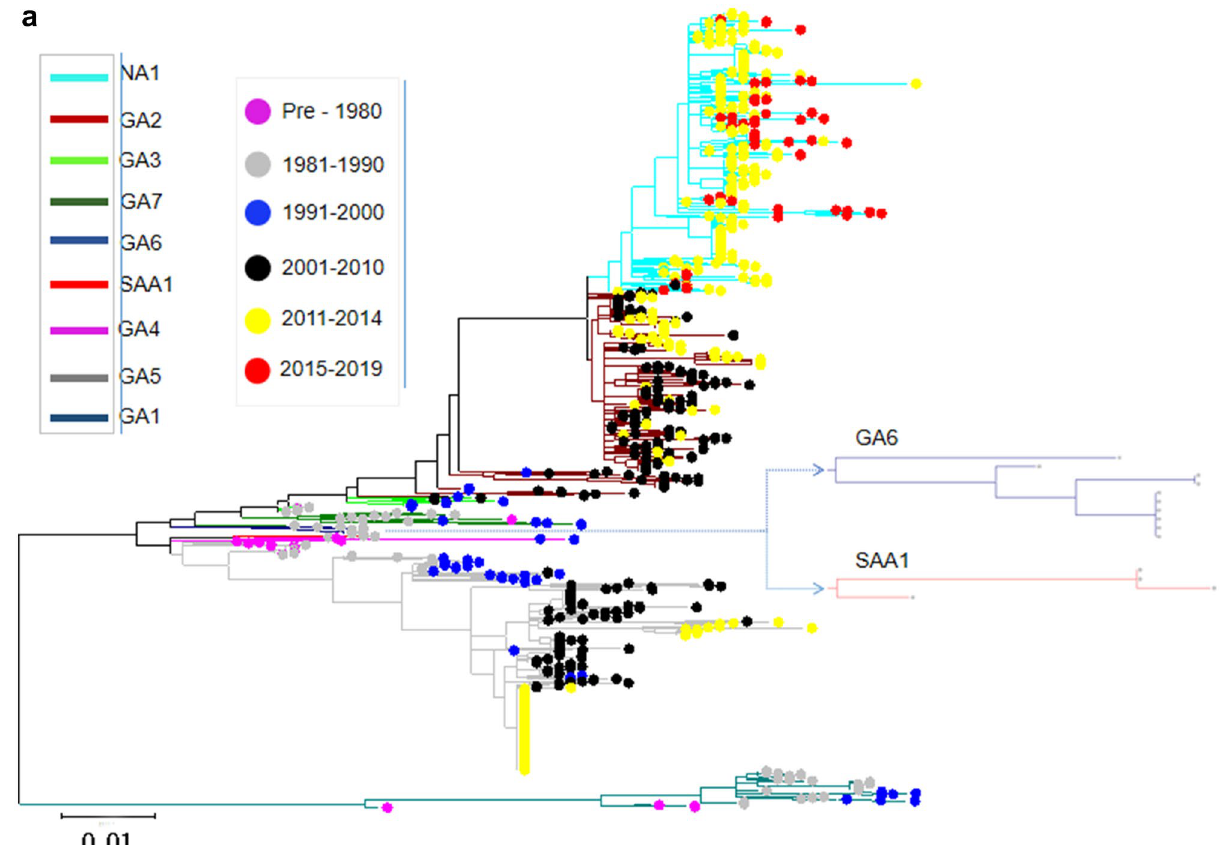
Figure 4. Temporal distribution of evolutionary clusters in the unrooted phylogenetic tree based on the RSV G gene sequence alignments using maximum likelihood method. ( a ) RSV-A: the invisible GA6 and SAA1 were further enlarged on the right side of the figure; ( b ) RSV-B. Dots with different color indicate sequences from different time, and lines with different color indicate different